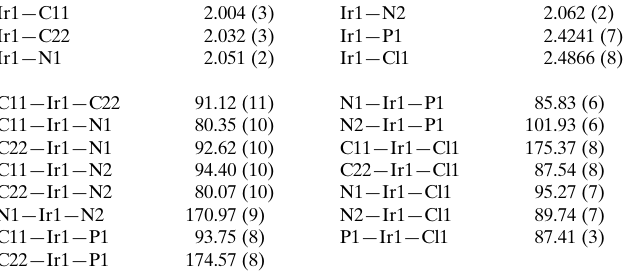
Table 1 Selected geometric parameters (A˚ , (cid:4) ).